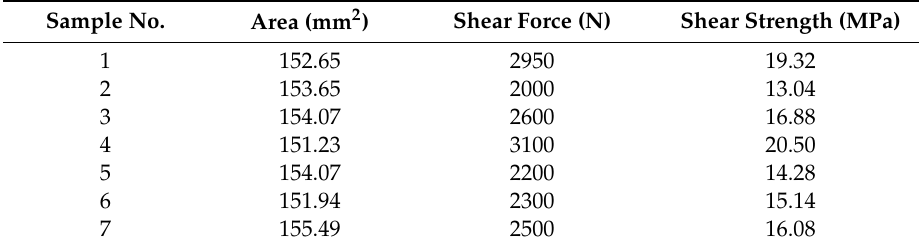
Table 3. Results of static shear test of soldered joints.